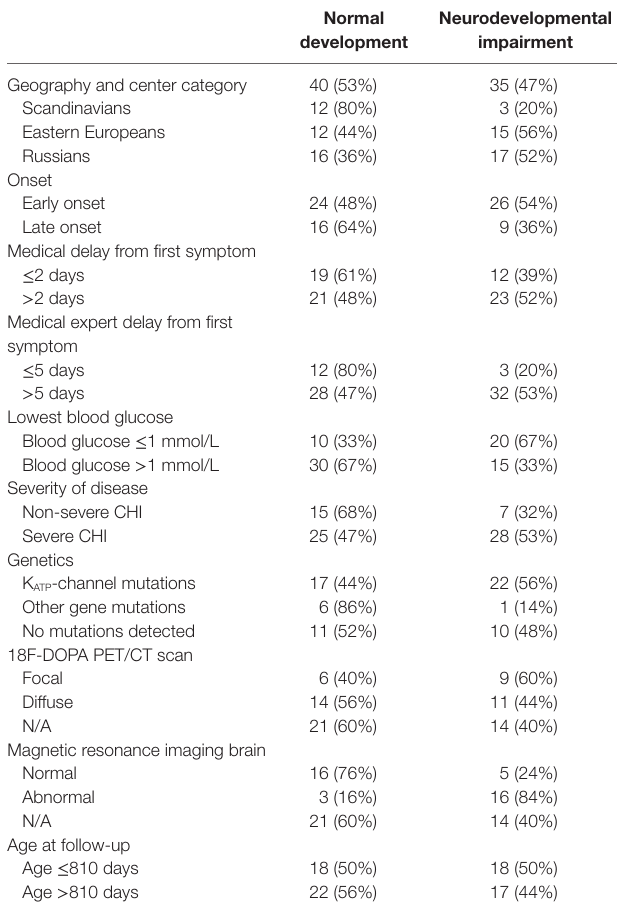
TaBle 6 | Overall neurodevelopmental outcome for children with congenital hyperinsulinism (CHI) by patient data.